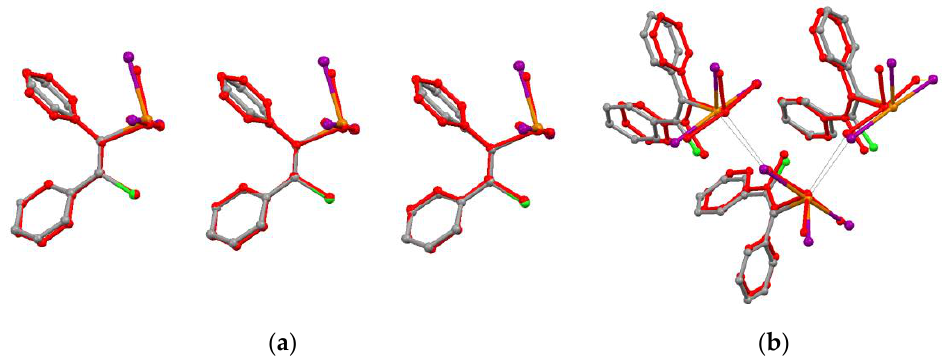
Figure 5. Crystal structure overlay of ( a ) the straight-chain fragments in 1α (red) and 2α , and ( b ) overlay of zigzag chains in 1β (red) and 2β .